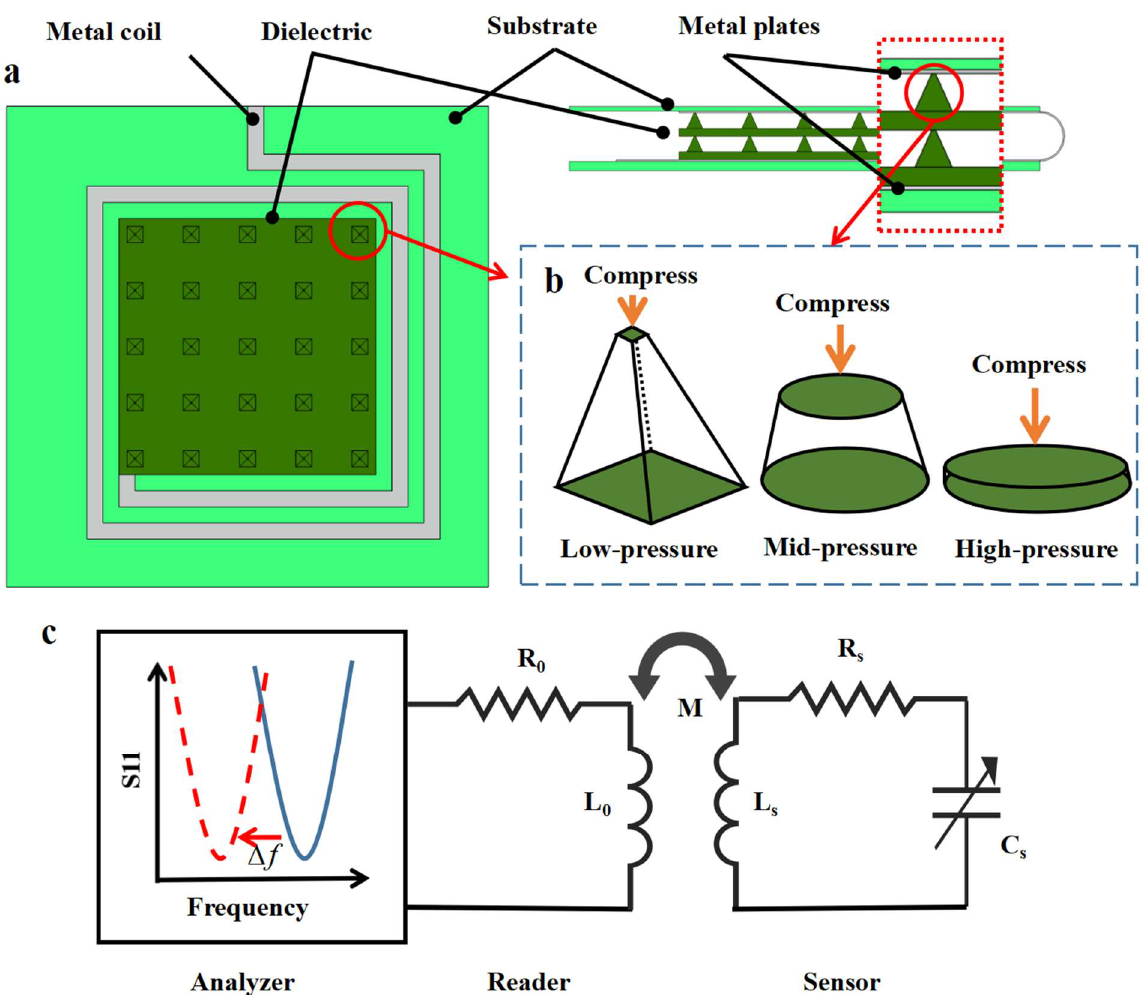
Figure 1. Schematic illustration of mechanisms and sensing of the radio-frequency (RF) pressure sensor. ( a ) Top view and side view of the RF sensor structure with the marks of main components. ( b ) The equivalent geometric changing model of the pyramid structure while under stress. ( c ) Diagram of the S11 curve changing while under stress and schematic circuit model of the RF sensor.